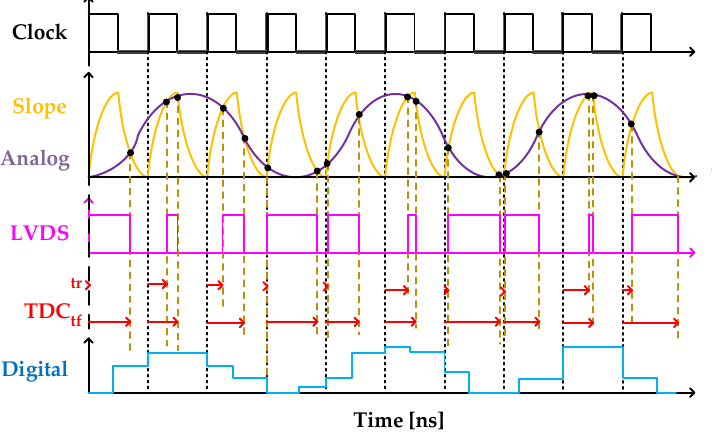
Figure 2. Timing diagram of our FPGA-based ADC. “Reproduced from